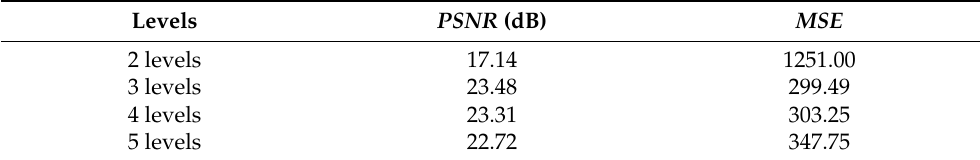
Table 2. The PSNR and MSE of different levels